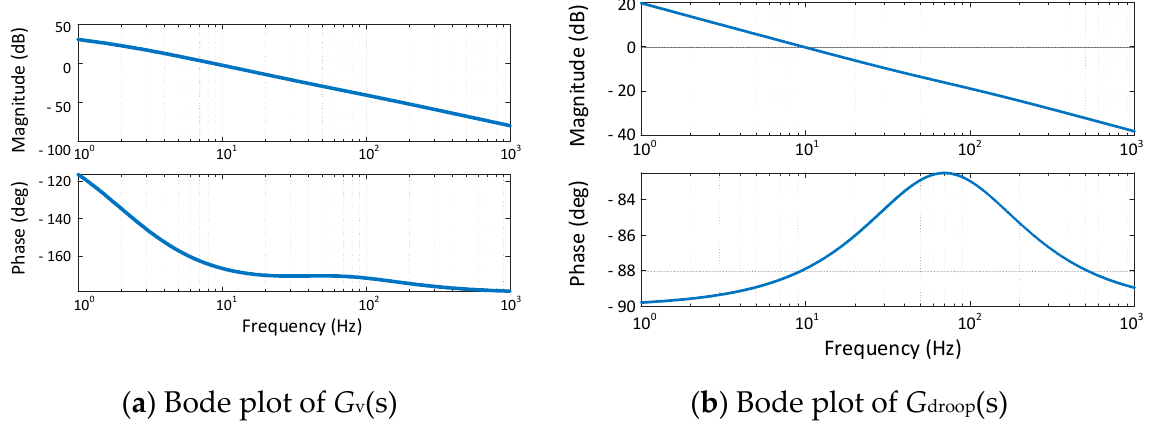
where K 1 and T 1 are the coefficients of the averaged DC/DC converter model, and K dpv and K div are PI controller coefficients. The corresponding bode plot is shown in Figure 7a. As indicated, there is enough of a phase margin to ensure the stability of the voltage loop.